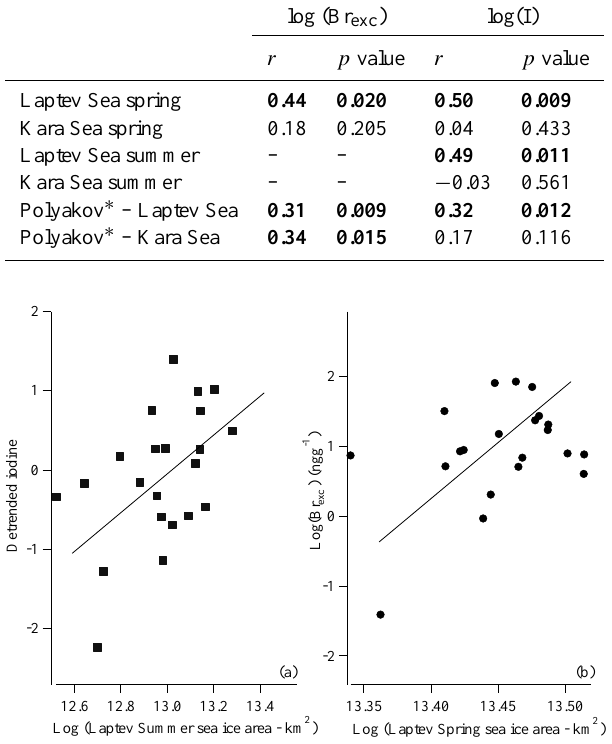
Figure 4. Scatterplot of log(Br exc ) and Laptev Sea spring sea ice area ( a – black squares) and detrended iodine and Laptev Sea sum- mer sea ice area ( b – black